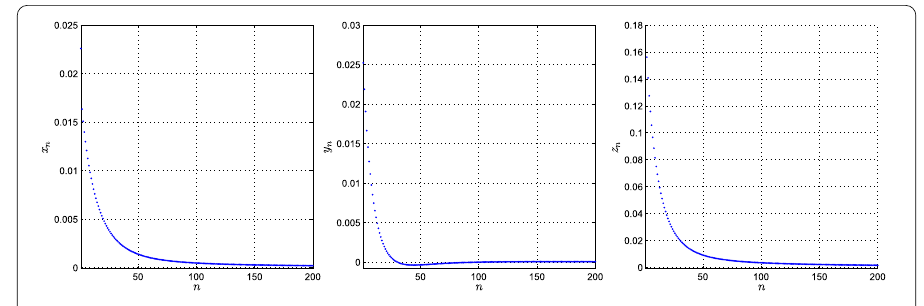
Figure 4 The states of the controlled